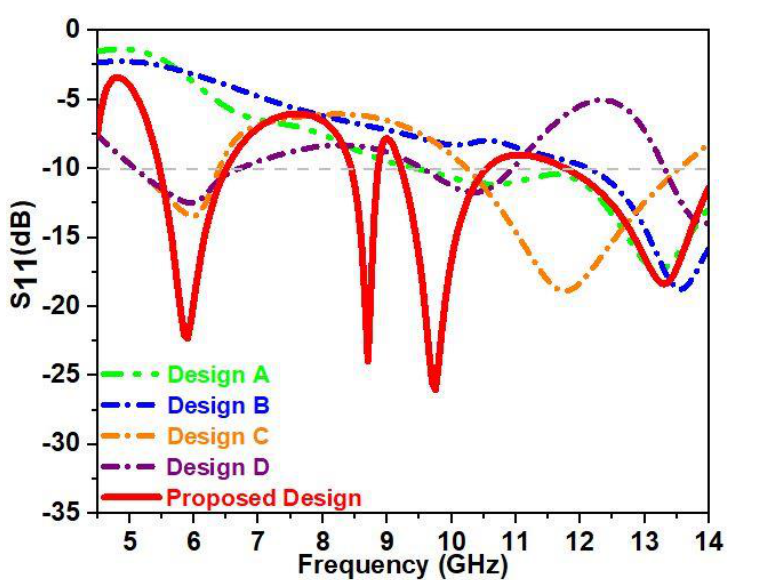
Figure 16. S 11 features of the progression stages.